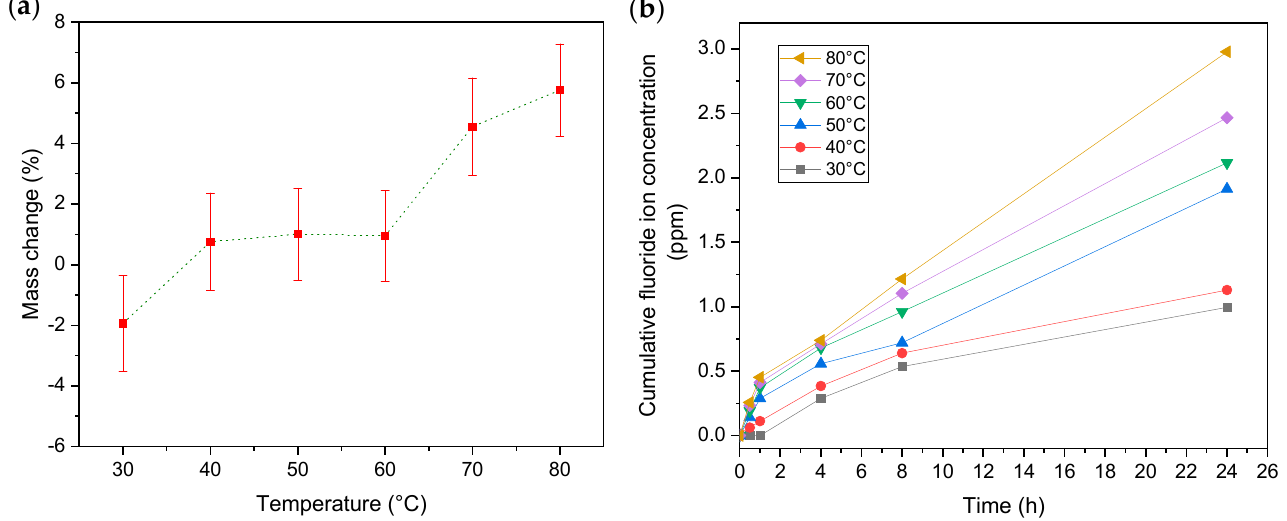
Figure 4. The e ff ects of temperature on the degradation behavior of Na fi on: ( a ) mass change (%) Figure 4. The effects of temperature on the degradation behavior of Nafion: ( a ) mass change (%) with respect to the initial mass of the Na fi on membrane after 24 h ex situ Fenton’s test at di ff erent with respect to the initial mass of the Nafion membrane after 24 h ex situ Fenton’s test at different temperatures; ( b ) cumulative fl uoride concentration (ppm) in the Fenton’s test solution with time; temperatures; ( b ) cumulative fluoride concentration (ppm) in the Fenton’s test solution with time; the horizontal axis of the graph is not linear. the horizontal axis of the graph is not